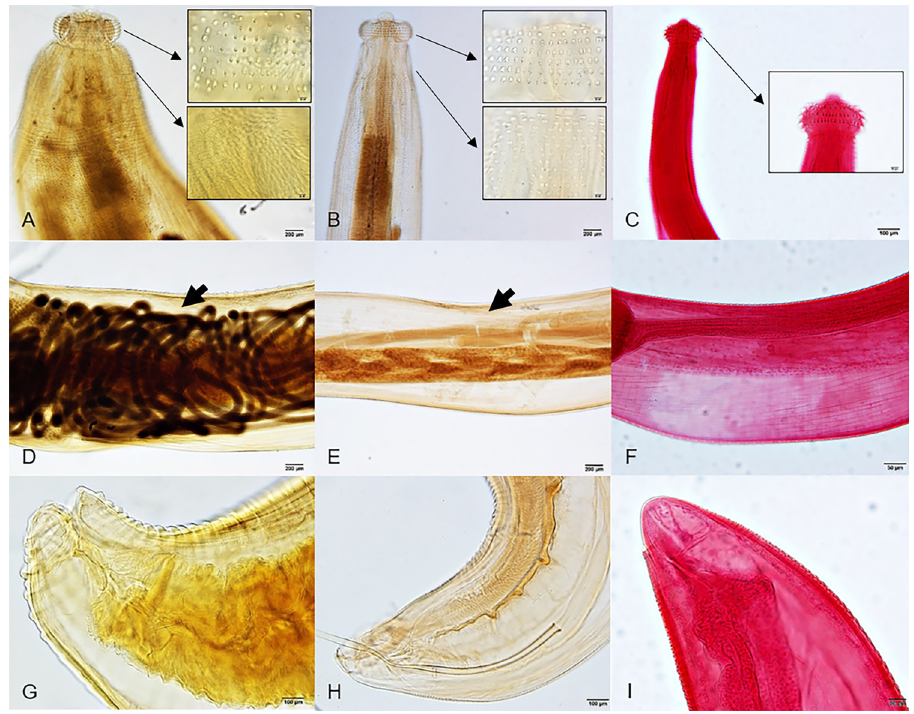
Fig 2. Light micrographs of permanent mount of Adults and permanent stain of AL3. Adult female (A, D, G) and male (B, E, H) with anterior (A), middle (D) and caudal (G) areas, respectively. Anterior cephalic hooklets and cuticular spines are shown in inset images (A-C).